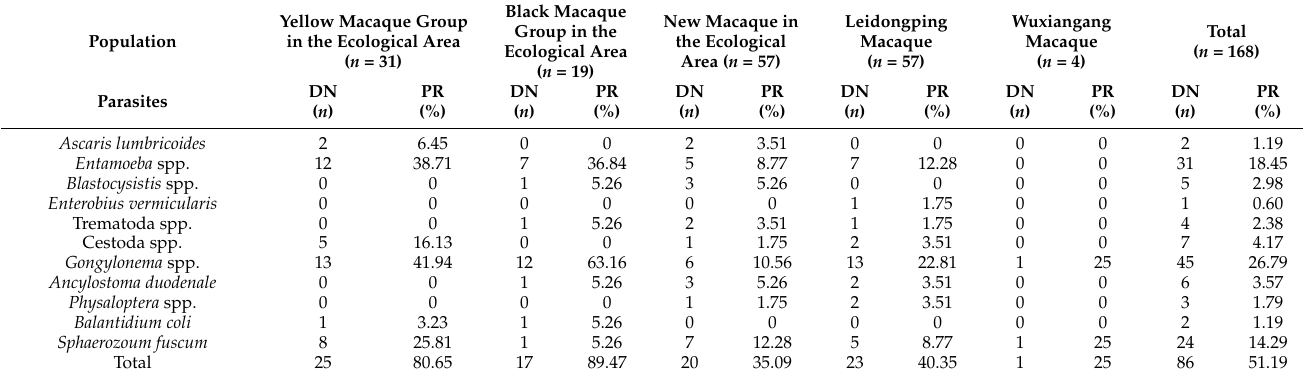
Table 3. Total prevalence rate of the intestinal parasites in macaques.